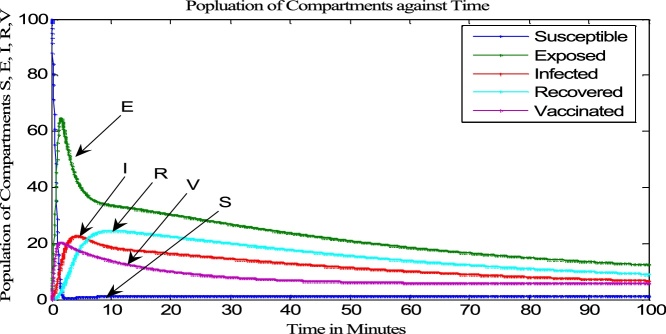
Time History of [13].